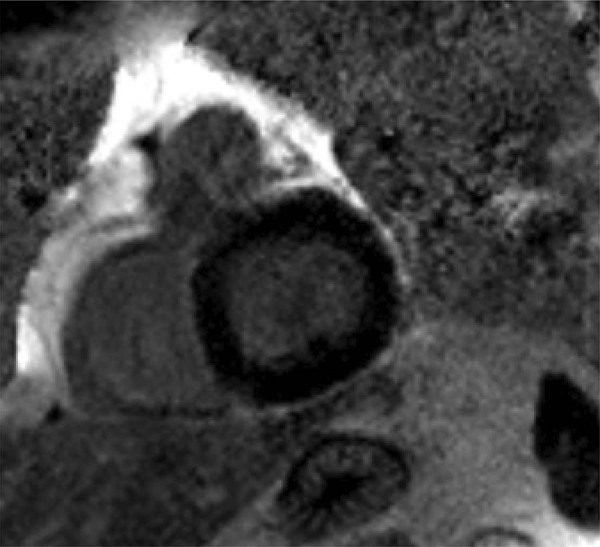
–
This image shows the appearance of normal myocardium. This particular image was obtained using Phase Sensitive Inversion Recovery (PSIR). There is no abnormal enhancement.